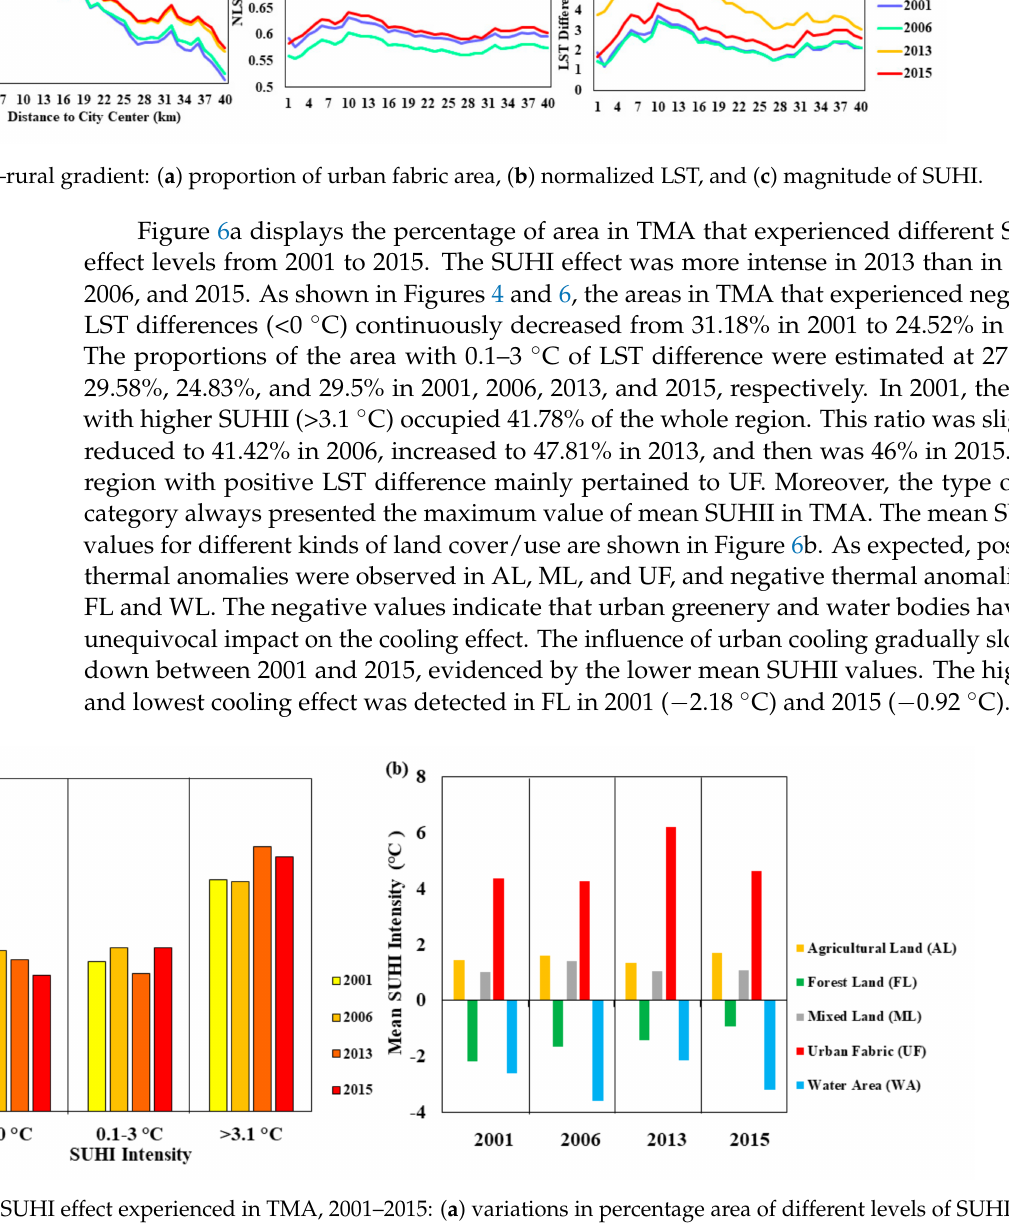
Figure 6. Trends of SUHI effect experienced in TMA, 2001–2015: ( a ) variations in percentage area of different levels of SUHI intensity and ( b ) variations in mean SUHI intensity of different land cover/use